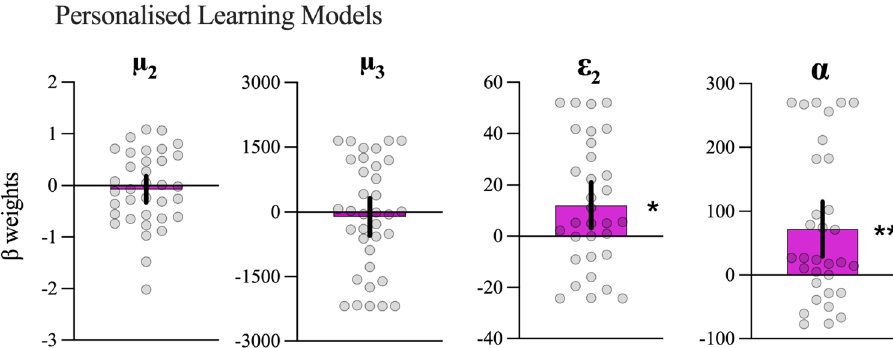
Figure 6. β weights for personalised learning models. Means and 95%CIs for beta weights for each parameter from the active inference models individually fit to each participant. * p < 0.05, ** p <